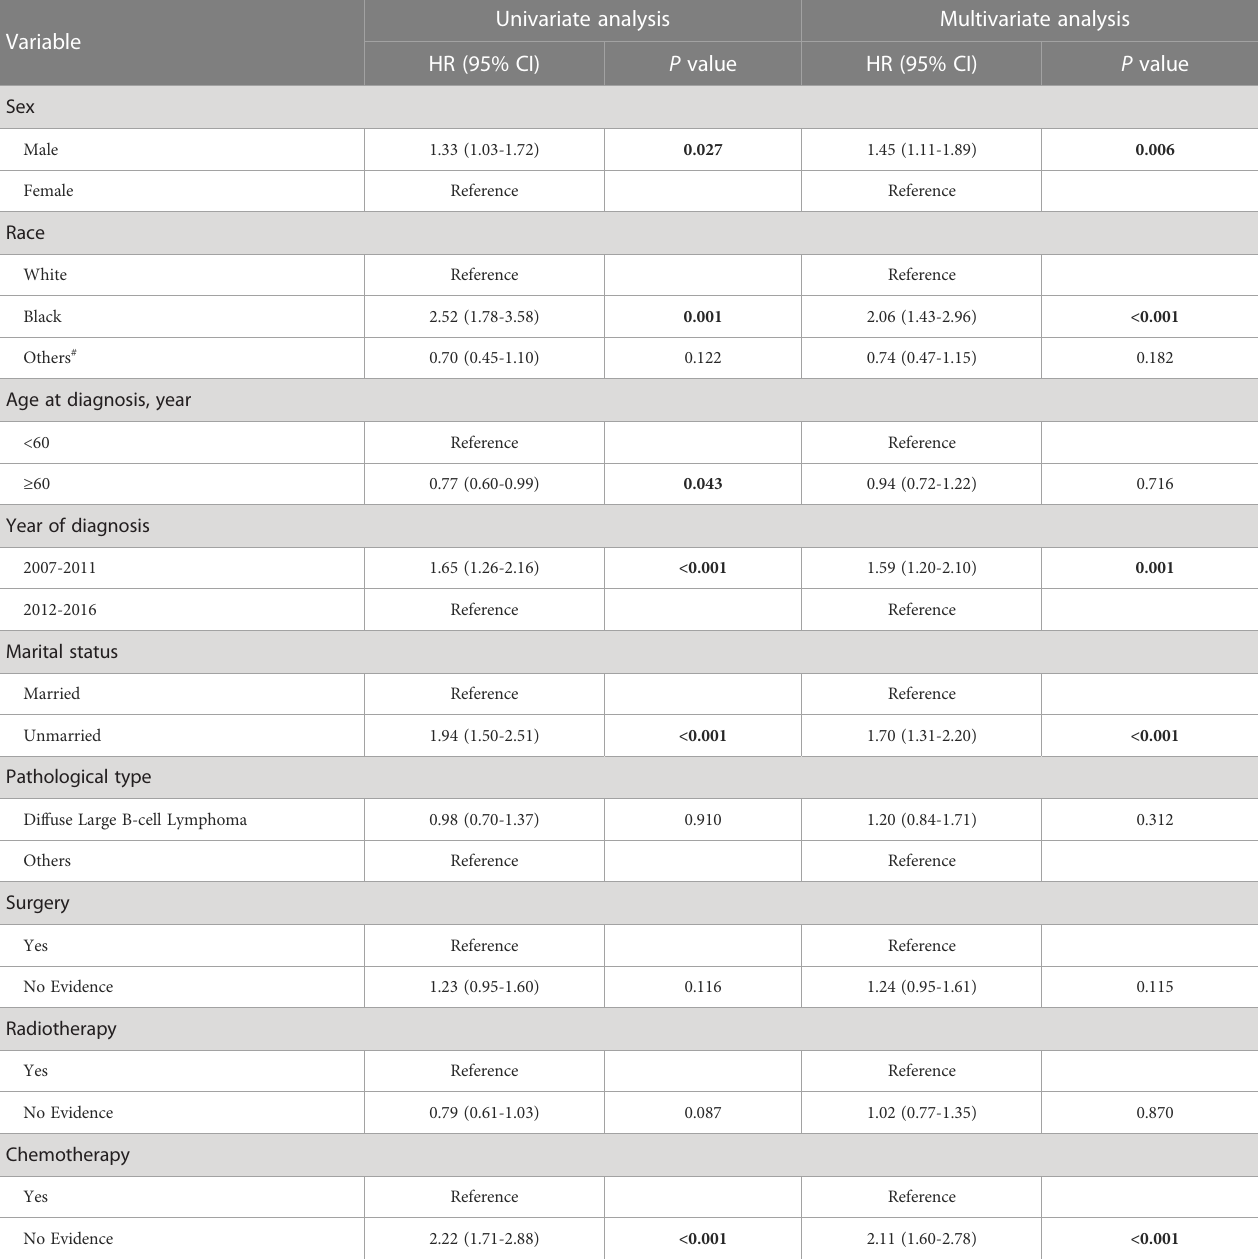
TABLE 4 Competing risk regression analyses of risk factors for non-cancer-speci fi c survival in PCNSL.